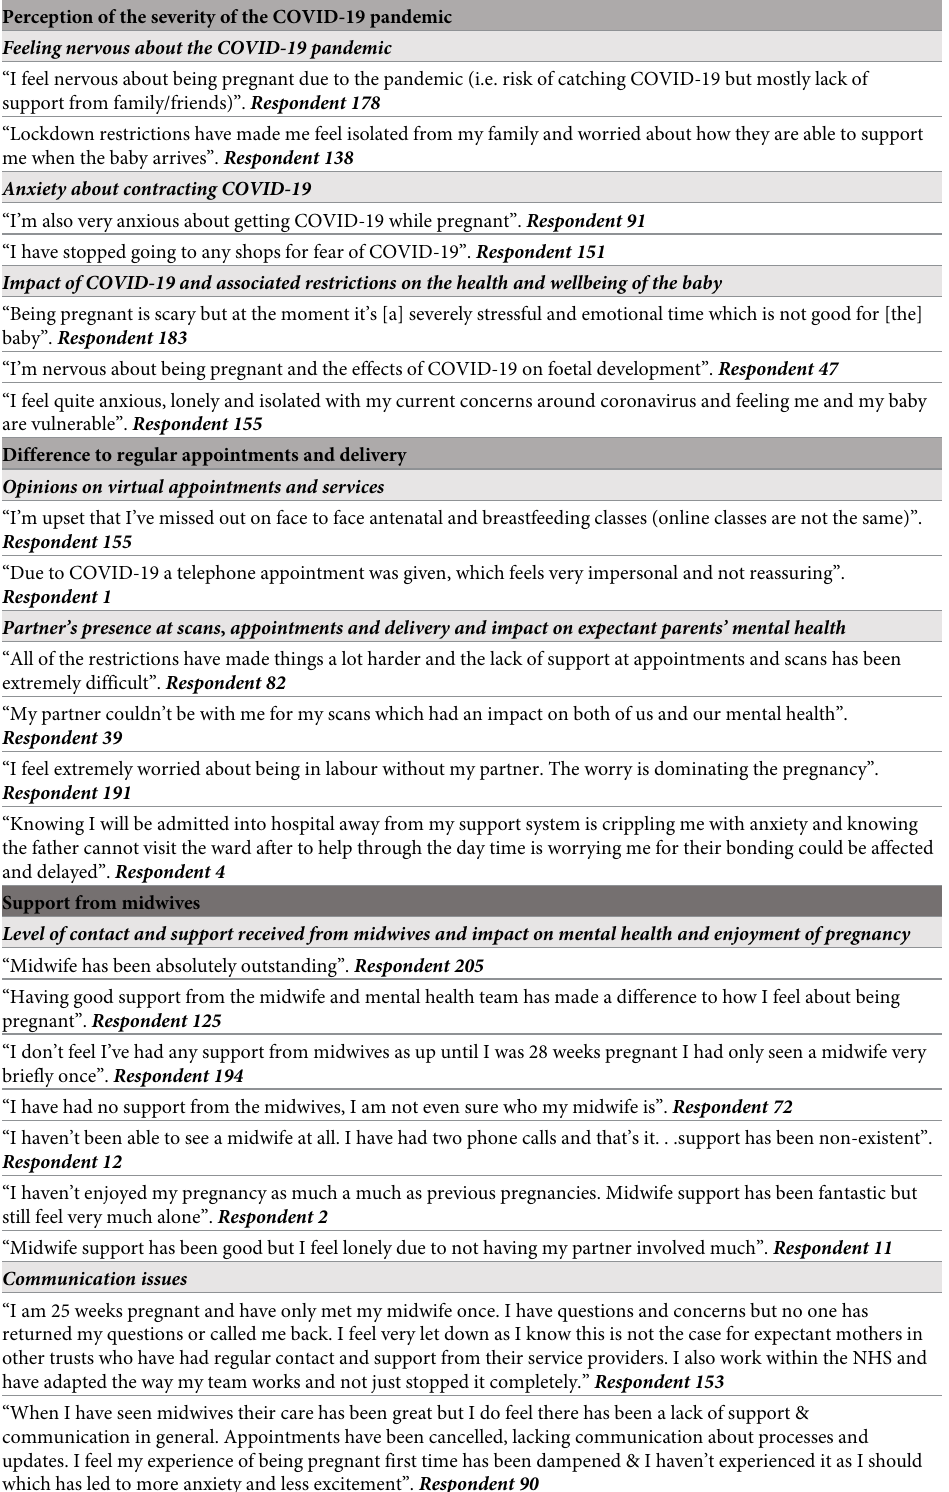
Table 2. Experiences of expectant mothers during the